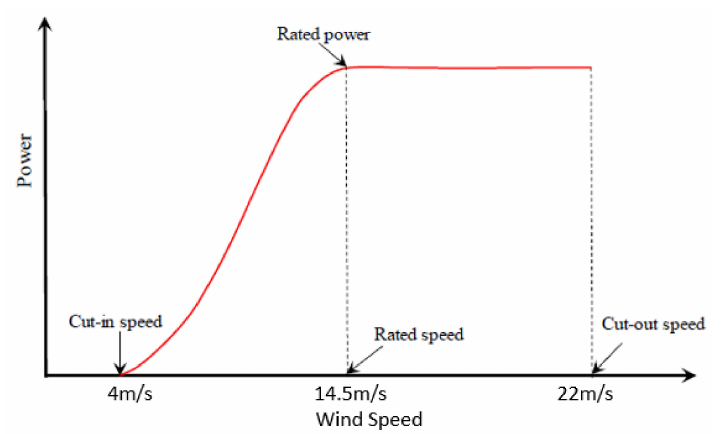
Figure 3. Typical WT Power vs. Wind Speed